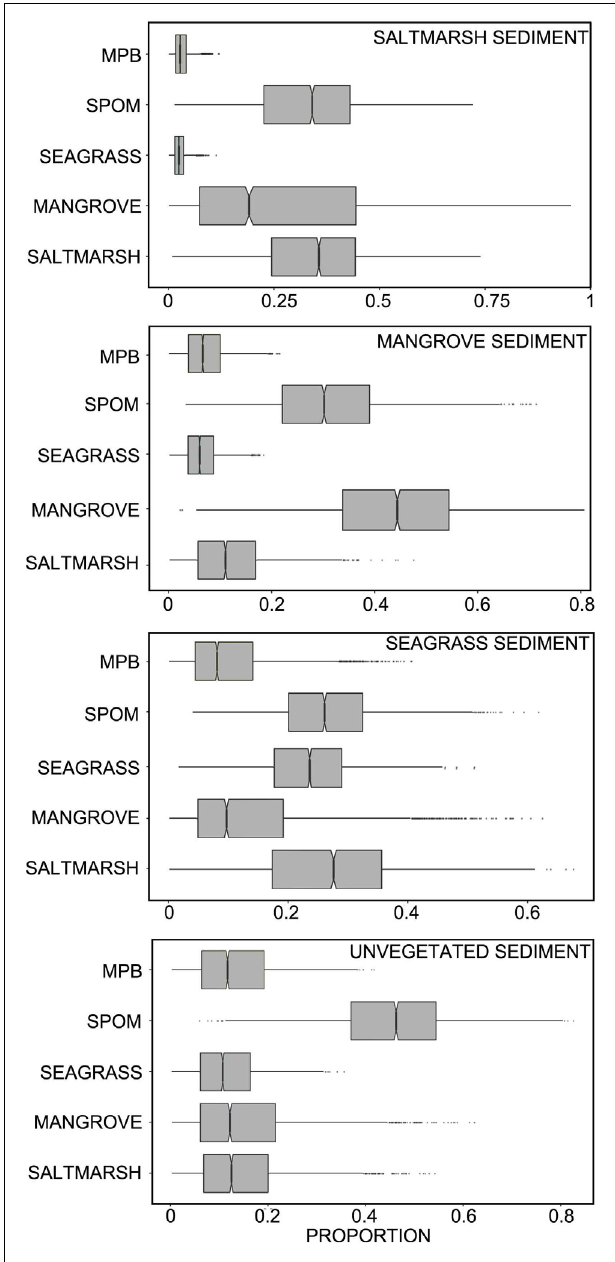
FIGURE 4 | Credibility interval plot of the contribution of di ff erent sources to sediment organic carbon within each habitat type based on SIMMR mixing model results (boxes enclose the 50% credibility interval; lines within boxes represent median values, tails represent 2.5 and 97.5% intervals). MPB , m icrophytobenthos ; SPOM , suspended particulate organic matter.